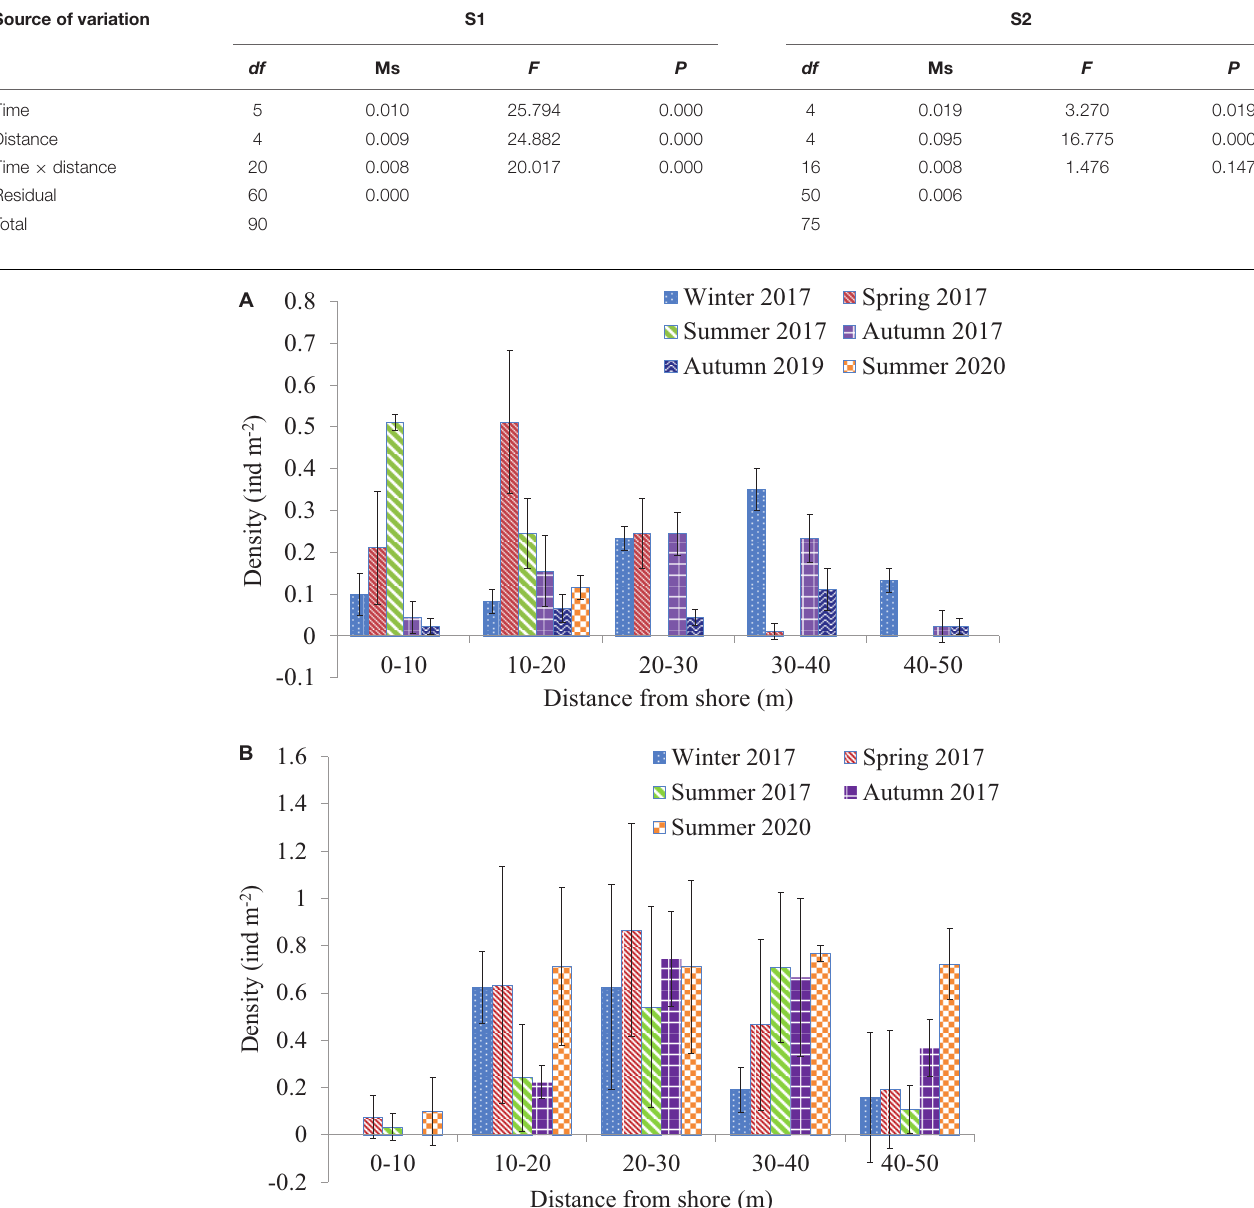
TABLE 3 | Results of two-way ANOVA on effects of sampling time (time) and distance from shore (distance) on Holothuria leucospilota density at 10-m increments along transects. Source of variation